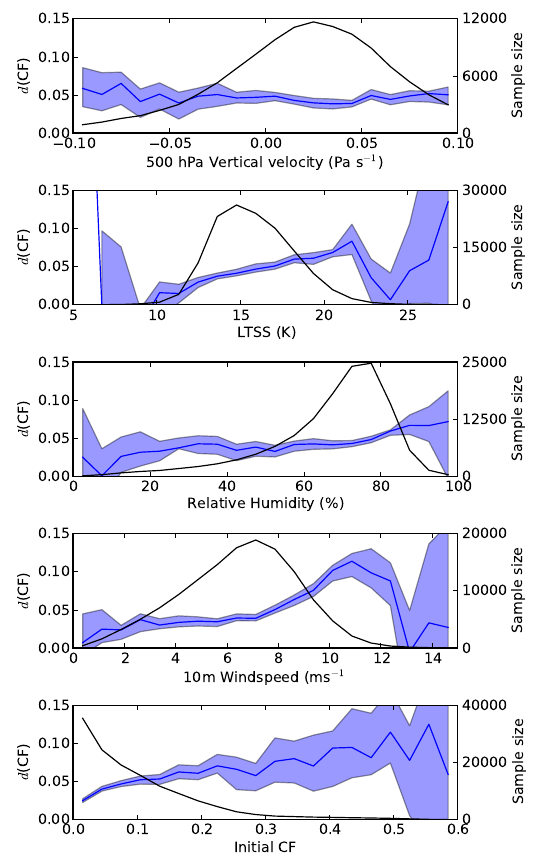
Fig. 6. The dependence of d (CF) (blue) on initial meteorological pa- rameters for the oceanic shallow cumulus regime. The distribution of points as a function of meteorological parameter is also shown by the solid black line. This plot is composed from MODIS data at all the oceanic shallow cumulus points over the years